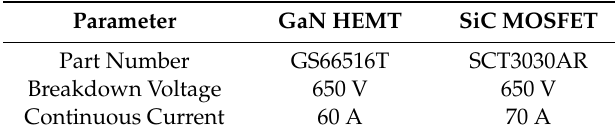
Table 1. Parameters of the selected devices